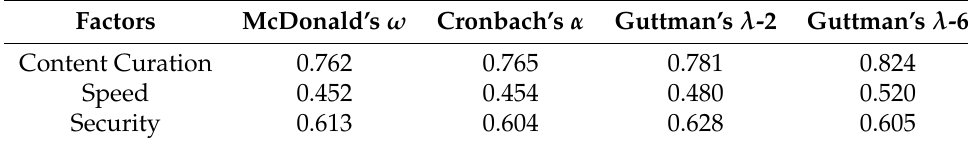
Table 3. Internal consistency and discriminant validity of the proposed Total Website SEO